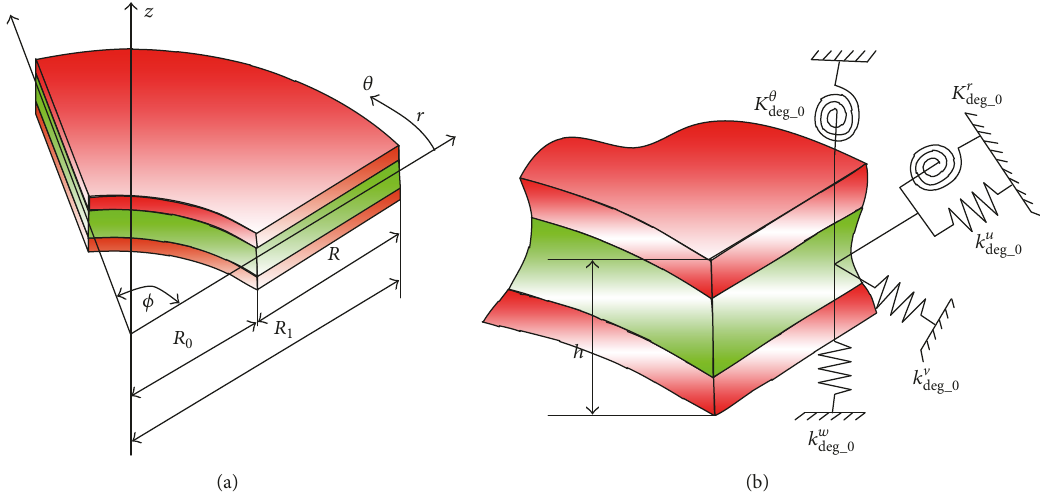
Figure 1: Schematic diagram of FG sandwich annular sector plate: (a) geometry and dimensions of an annular sector plate; (b) partial boundary spring view of the annular sector